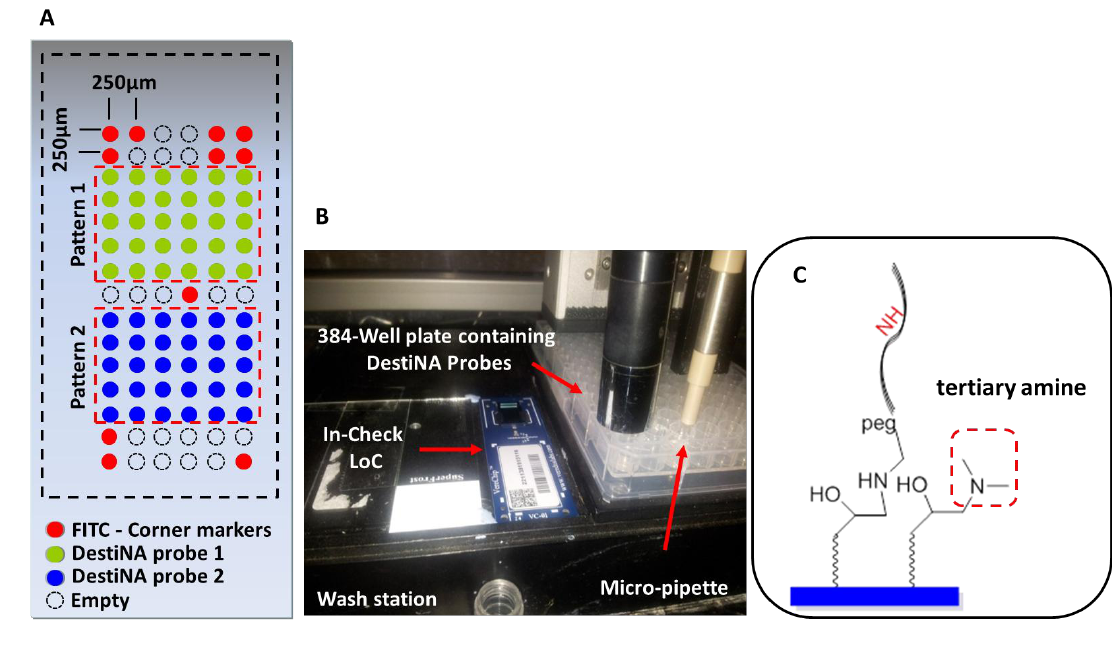
Figure 5. ( A ) Graphic layout of the microarray. ( B ) Printing station with a microdrop printer GmbH (Norderstedt, Germany) containing a micro-pipette with a 70 µm diameter nozzle. ( C ) Efficient blocking using 150 mM phosphate buffer containing 50 mM dimethylamine. Red square shows the tertiary amines